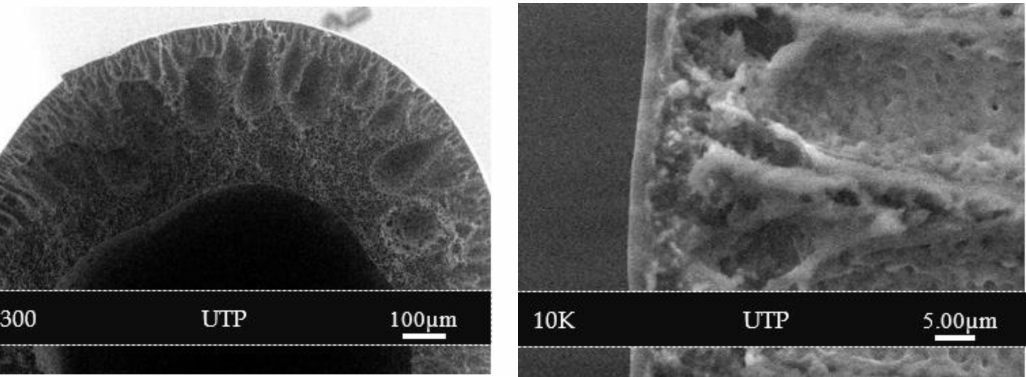
Figure 4. Cross-section morphology of PSf/PDMS membrane (C) at 300 and 10 K